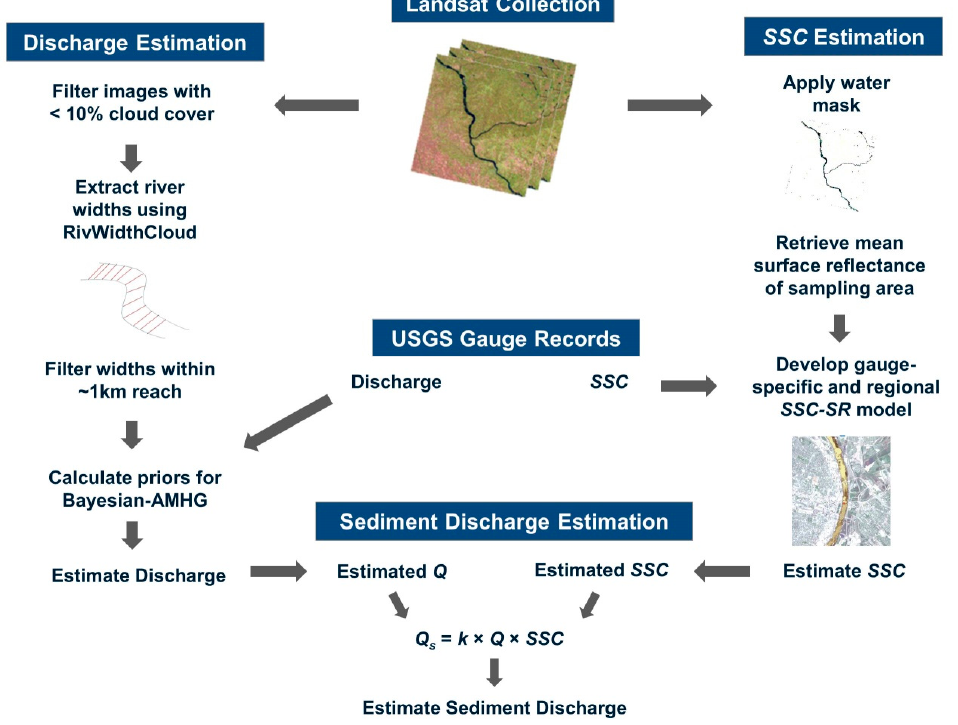
Figure 5. Flowchart of estimating sediment discharge with Landsat imagery.